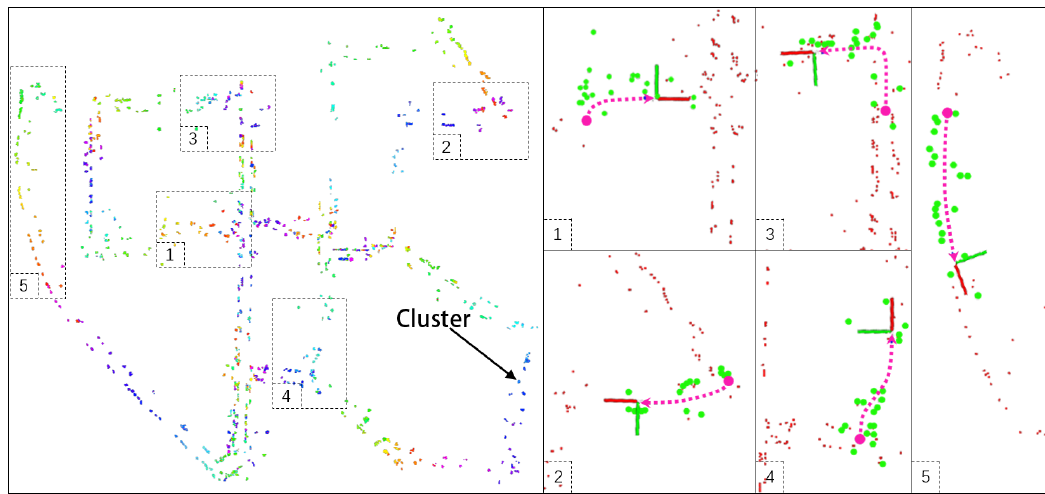
Figure 10. Experimental results of relocalization on KITTI